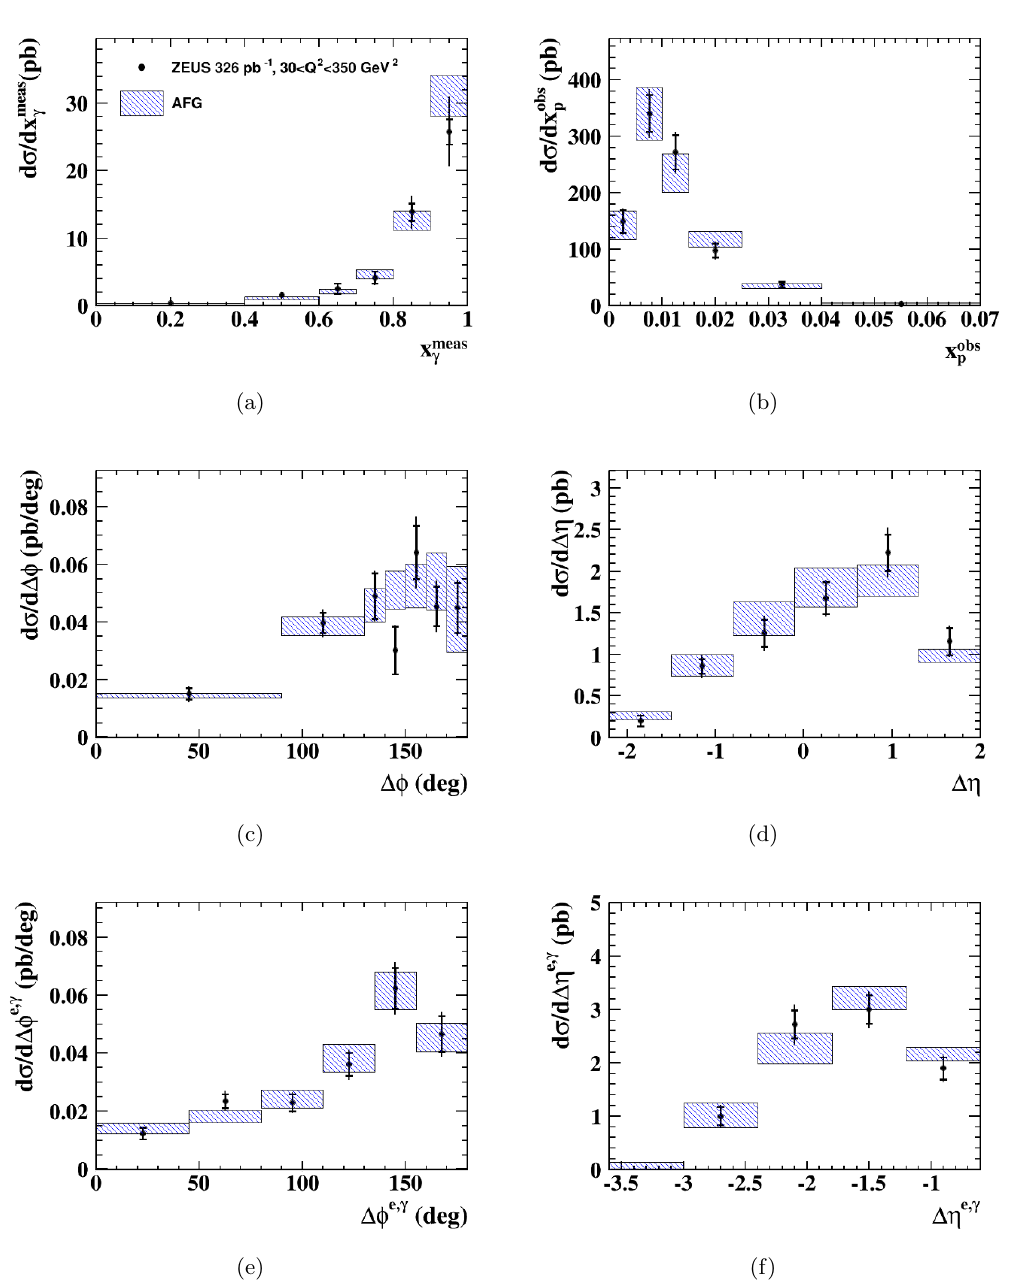
Figure 9 . Di(cid:11)erential cross sections for selected variables in the region 30 (cid:20) Q 2 < 350 GeV 2 as in (cid:12)gures 4, 5. Theoretical predictions from Aurenche et al. (AFG) are shown, with associated uncertainties indicated by the bands.